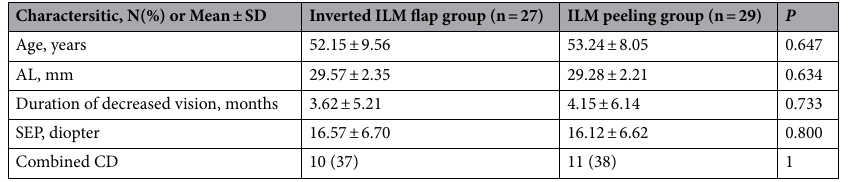
Table 1. Comparison of Baseline Clinical Factors. ILM Internal limiting membrane, AL Axial length, SEP Spherical equivalent power, CD choriodal detachment.